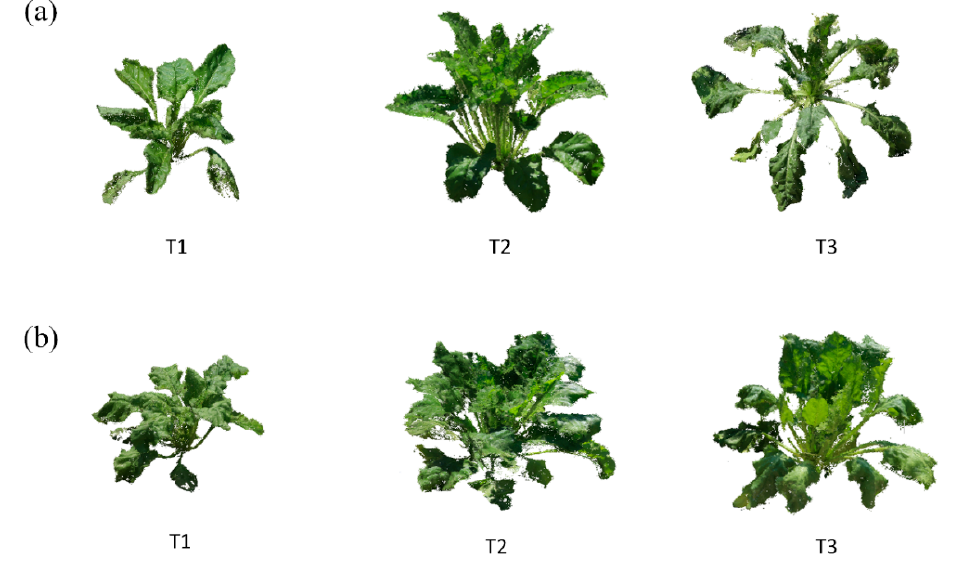
Figure 6. Point cloud of individual plant at three growth stages (T1, T2 and T3) with plant type of scattered leaves ( a ) and gathered leaves ( b ).